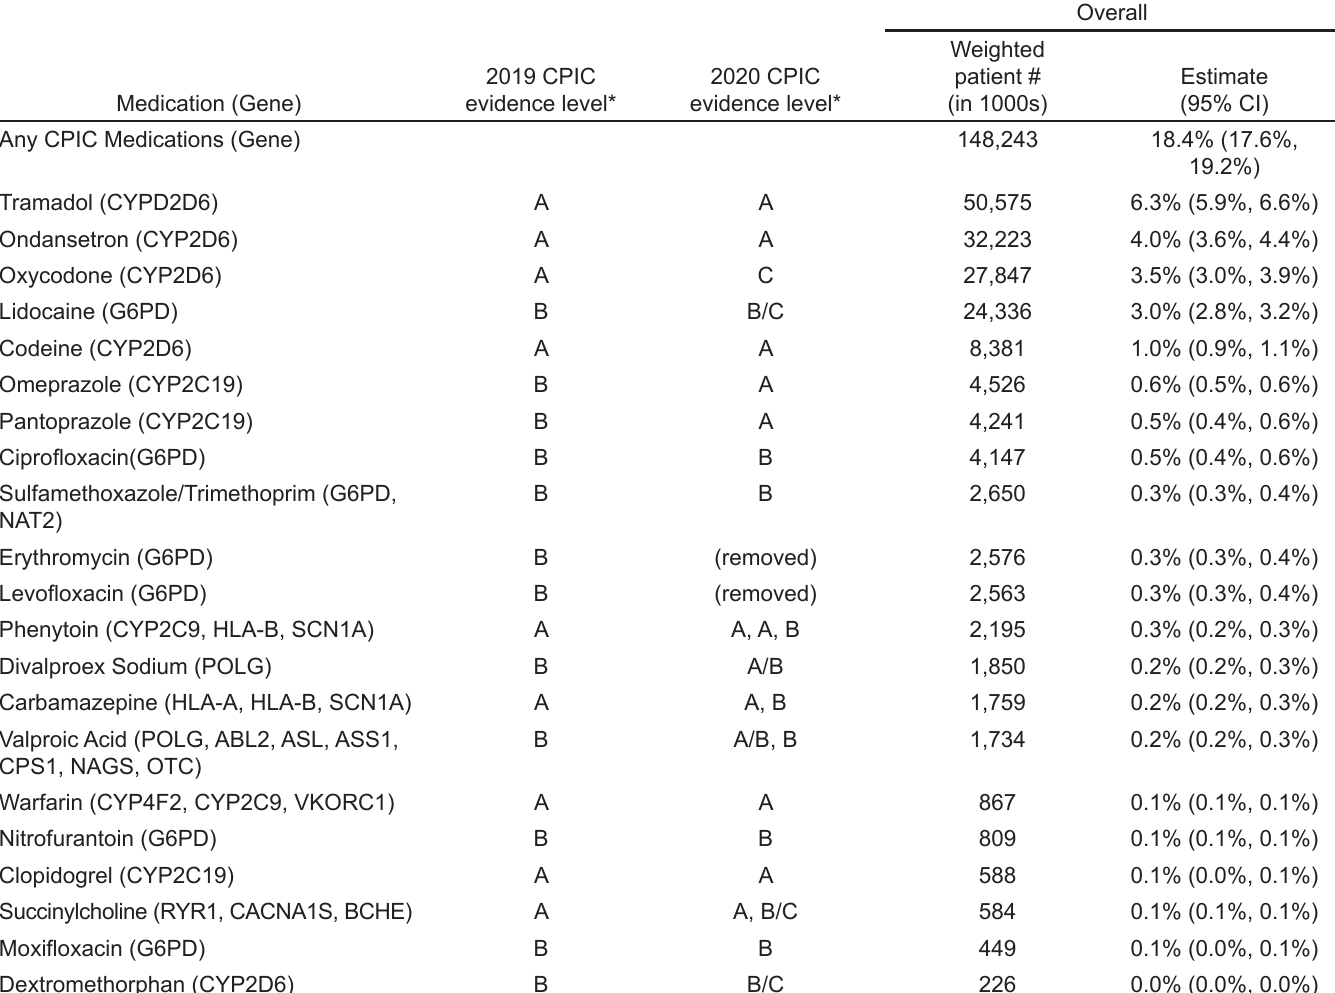
Table 2. Rates of visits by common emergency department CPIC